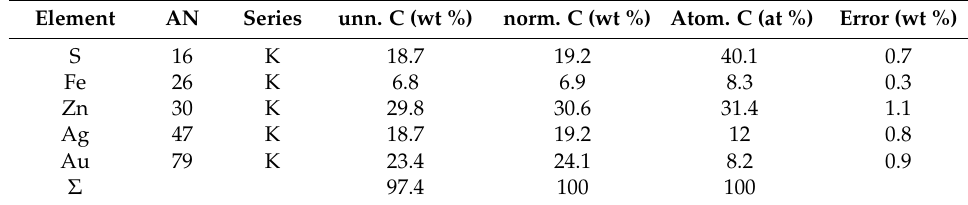
Table 7. Chemical composition of Au-Ag inclusion in wt %/at % (EPMA-EDX) (AN = atomic number, series = emitted X-ray series, unn. C = non corrected carbon, norm. C = normalized carbon, Atom. C = corrected atomic